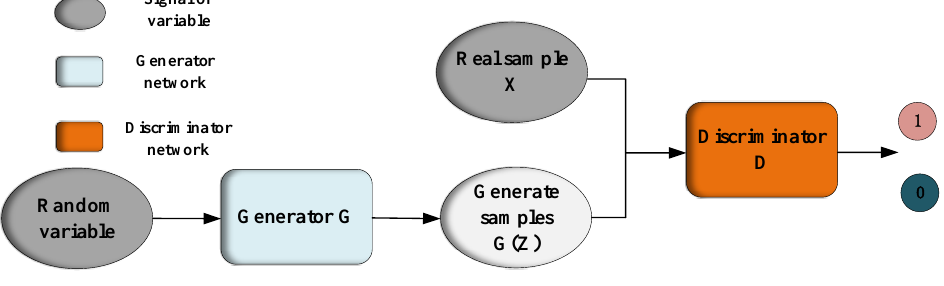
Figure 1. GAN structure.